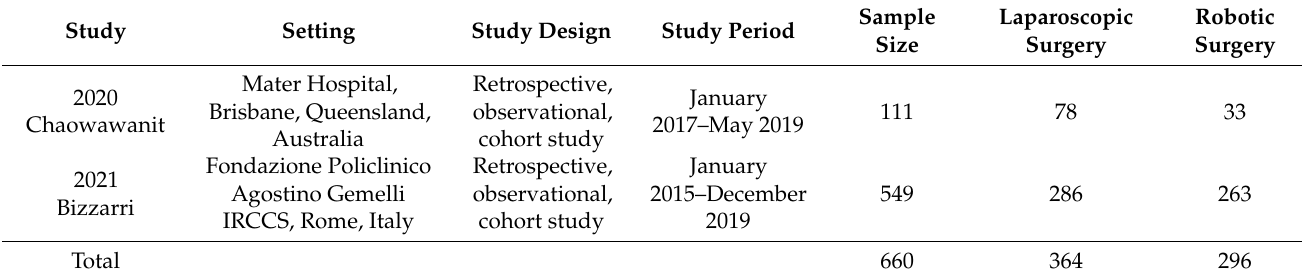
Table 1. Characteristics of included